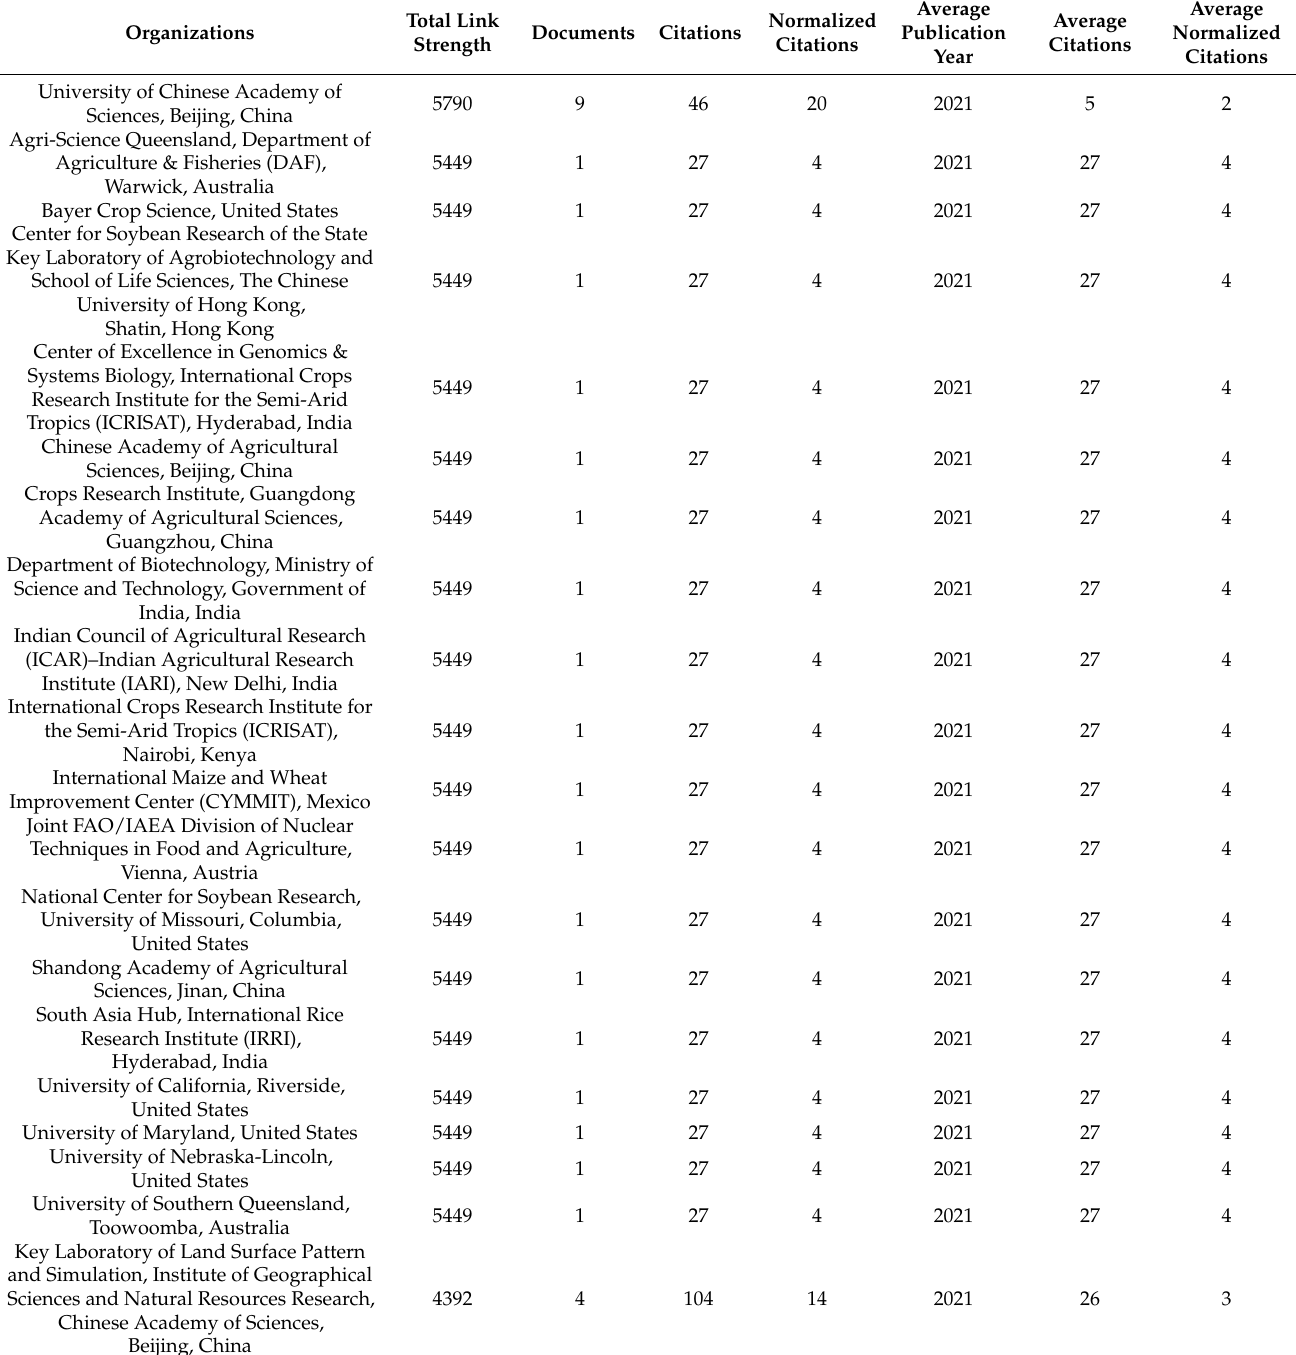
Table 4. Top 20 organizations with the highest total link strength for bibliographic data, considering full counting and 1 as the minimum number of occurrences of an